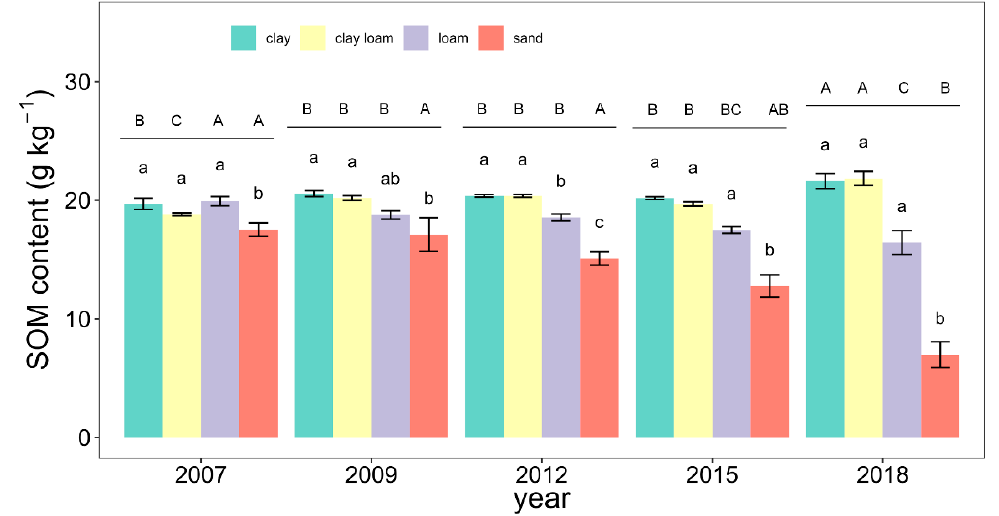
Figure 7. Soil organic matter (SOM) content for main soil texture at different times. Notes: Different uppercase letters represent significant differences among years in the same soil texture, and different lowercase letters represent significant differences among soil texture in the same year, according to the least-significant difference (LSD) test at α = 0.05 level of probability.